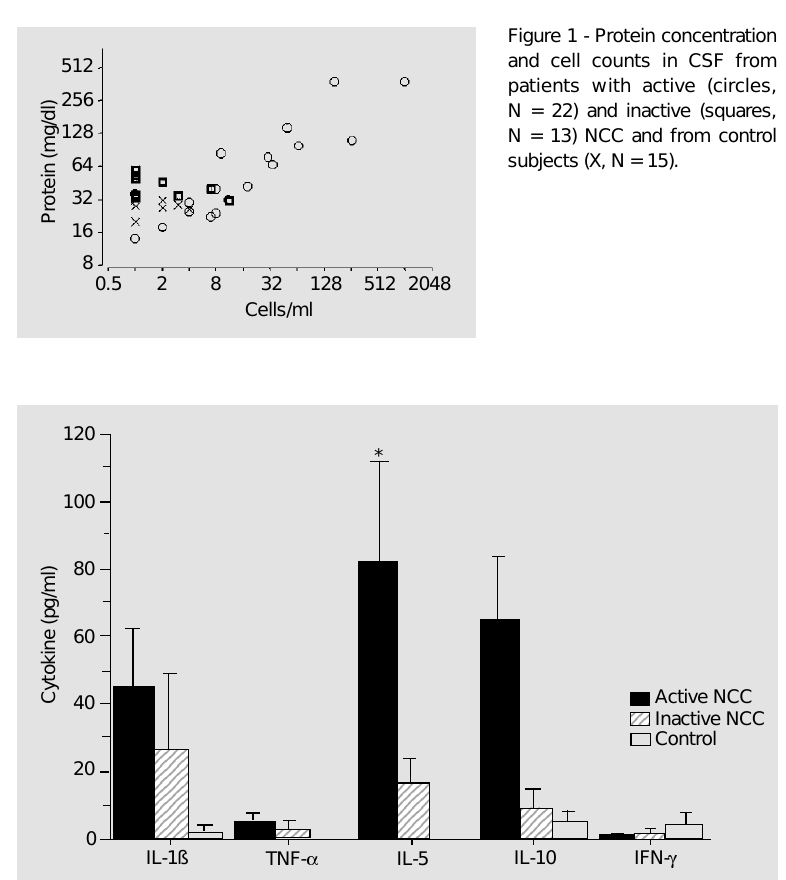
Figure 2 - Cytokine levels in CSF from patients with active (filled bars, N = 22) and inactive (striped bars, N = 13) NCC and from control subjects (open bars, N = 15). The bar represents the mean and the vertical lines the standard error of the mean. Statistical analysis was performed on log-transformed cytokine levels. *P<0.05 compared to control subjects (Student t